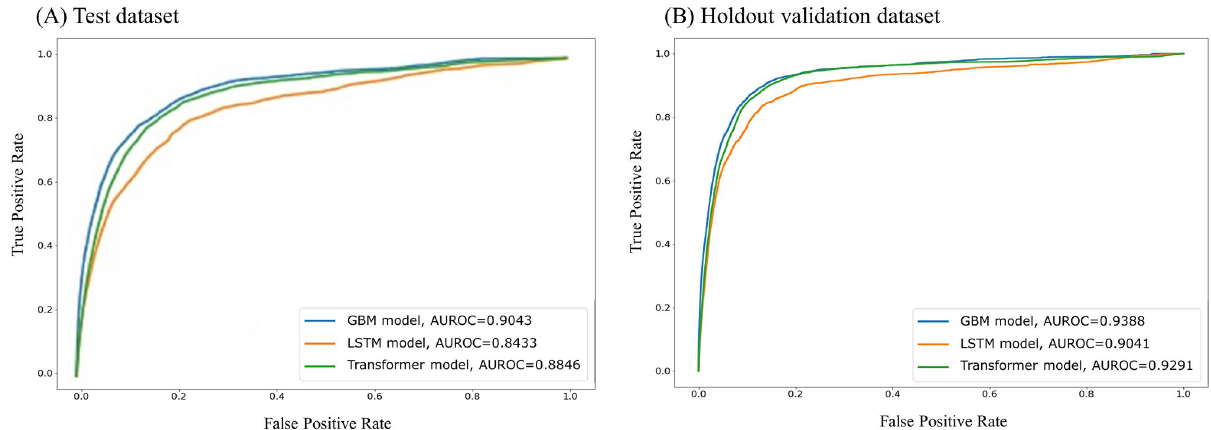
Fig 2. Comparison of area under the receiver operating characteristic curves for the machine learning models for predicting intraoperative hypoxemia in pediatric patients in (A) test dataset (B) holdout validation dataset. GBM, Gradient-boosting model; LSTM, Long short-term memory; AUROC, Area under the receiver operating characteristic curve.